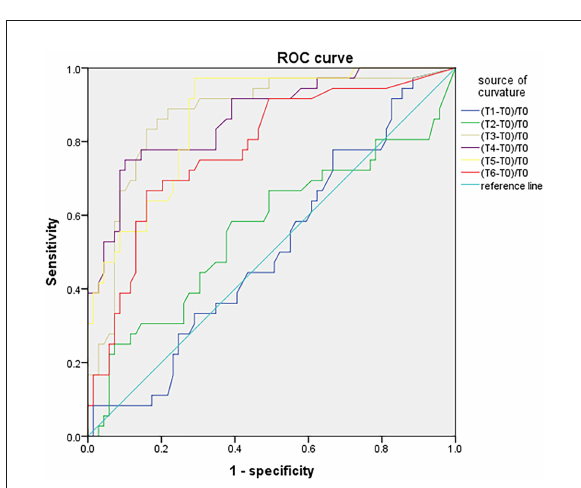
FIGURE4 ROC curve analysis of PND predicted by the maximum percentage decline of SctO 2 at each time point.